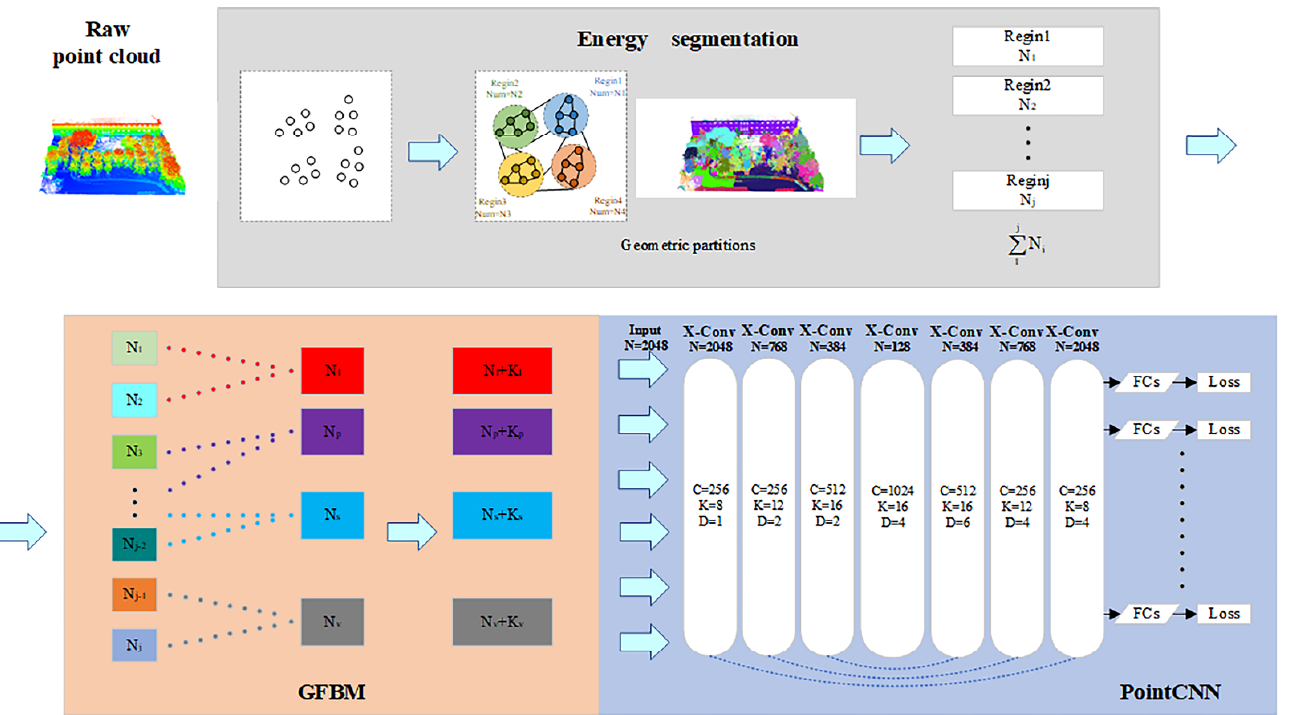
Figure 6. The deep learning network structure in this paper, where N 1 – N j represent each geometric partition; N l , N p , N s , and N v represent the point clouds of linear, planarity, scattering, and vertical as the main features, respectively; K l , K p , K s , and K v represent the point clouds of each feature added after the geometric features are balanced. In PointCNN, in each X-Conv operation, N represents the number of points in the next layer, C represents feature dimensionality, K rep-resents the number of nearest neighbors, and D represents the dilation rate.